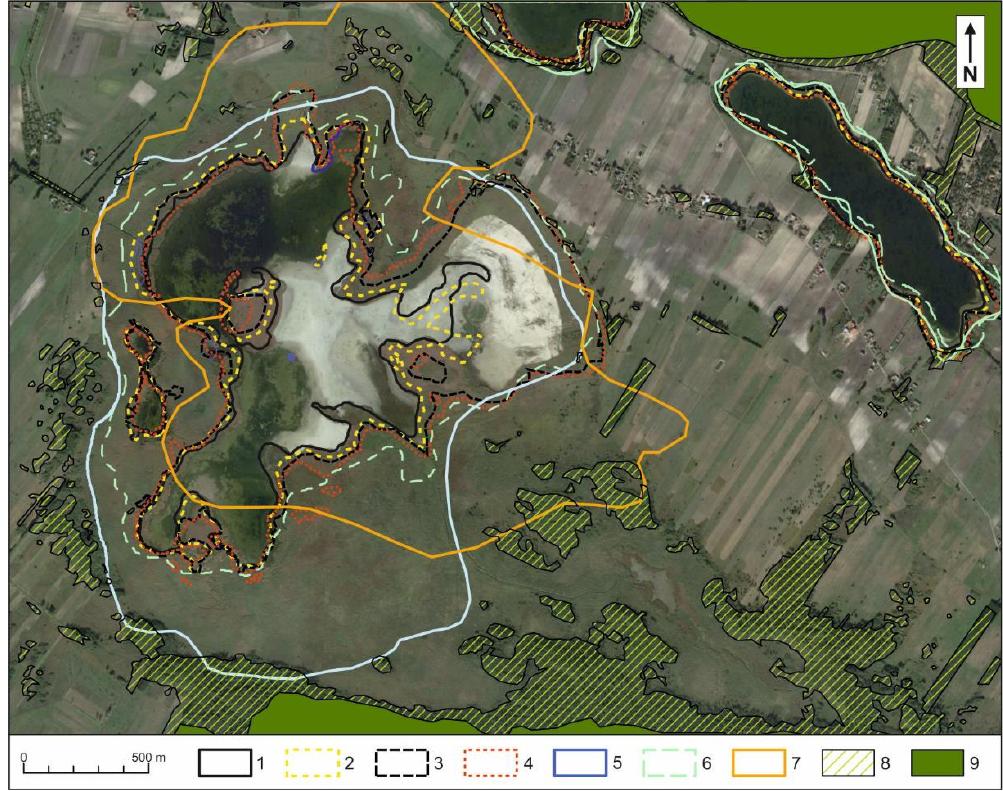
Figure 4. The range of Rakutowskie Lake and the forest areas in 1911–2009 mapped on Google